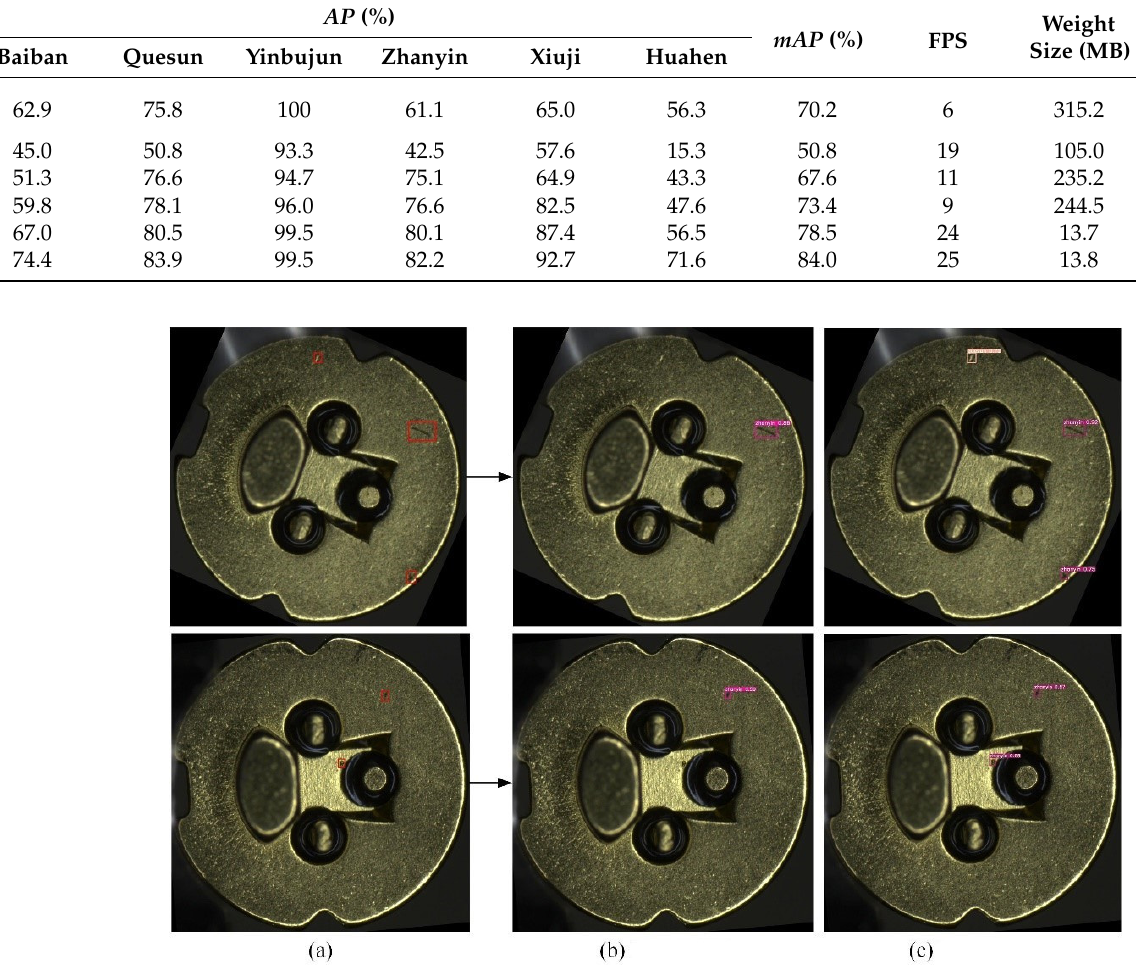
Figure 11. Detection results of another type of metal TO-base: ( a ) ground truth box; ( b ) predictions of YOLO-V5; ( c ) predictions of YOLO-SO.